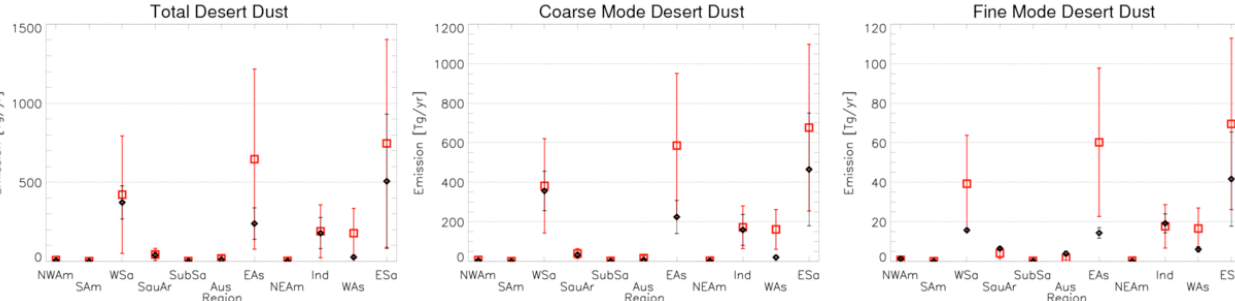
Fig. 9. Annual emissions of coarse mode, fine mode and total desert dust in North West America (NWAm), South America (SAm), West Sahara (WSa), Saudi Arabia (SauAr), Africa Sub Sahara (SubSa), Australia (Au), East Asia (EAs), North East America (NEAm), India (Ind), West Asia (WAs) and East Sahara (ESa). Emission fluxes of the first guess (FG, red) and analysis (AN, black) are illustrated. Vertical bars correspond to the uncertainties in the emissions and represent one standard deviation. Regions correspond to the ones illustrated in Fig. 1.